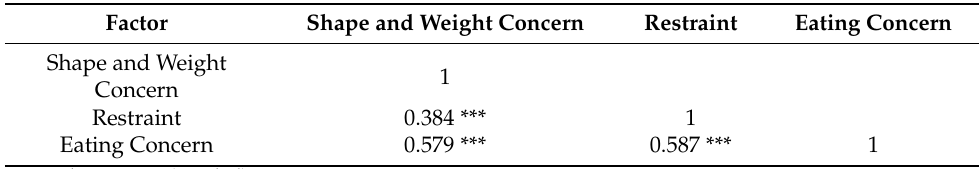
Table 4. Factor correlation matrix by EFA (first half split of dataset, n =